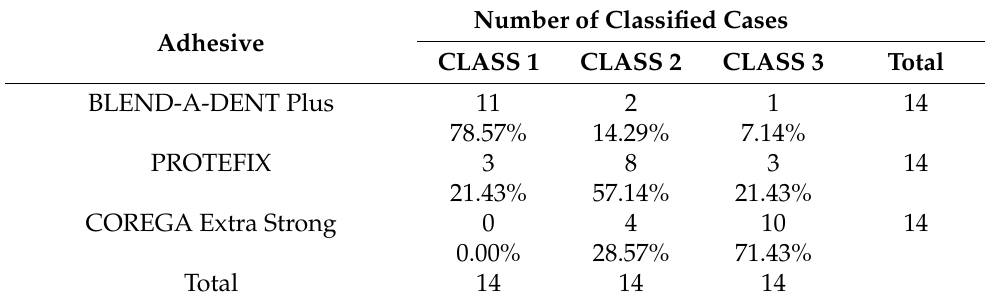
Table 6. Classification of denture adhesives BLEND-A-DENT Plus, PROTEFIX and COREGA Extra Strong for their cytotoxic effect.